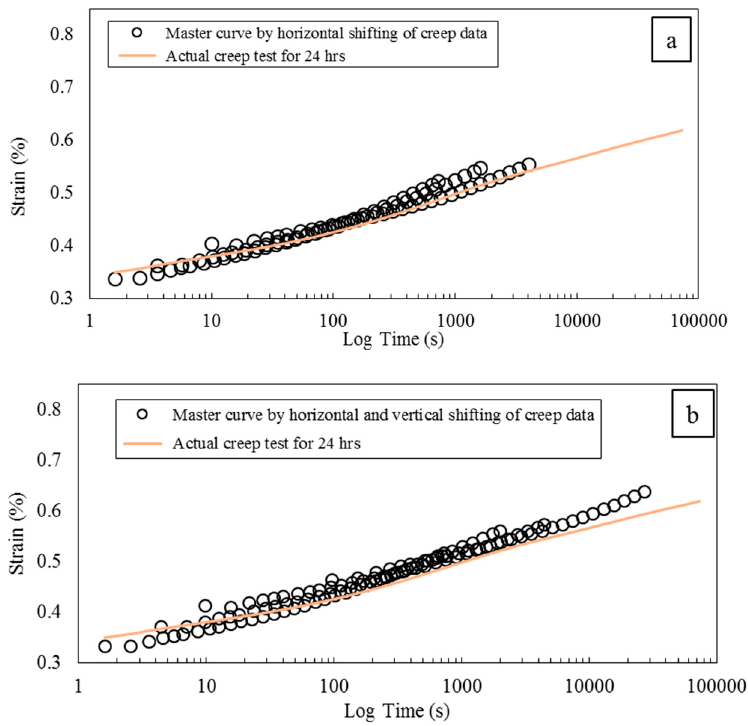
Figure 15. Comparison of actual creep data for 24 h with ( a ) master curve generated by horizontal shifting of creep data; ( b ) master curve generated by horizontal and vertical shift of creep data.